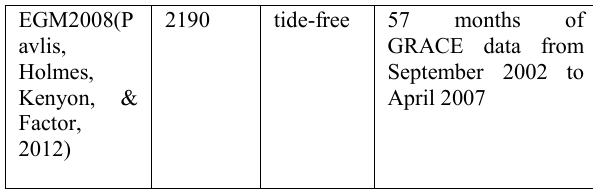
Table 1. Description of different gravity models.